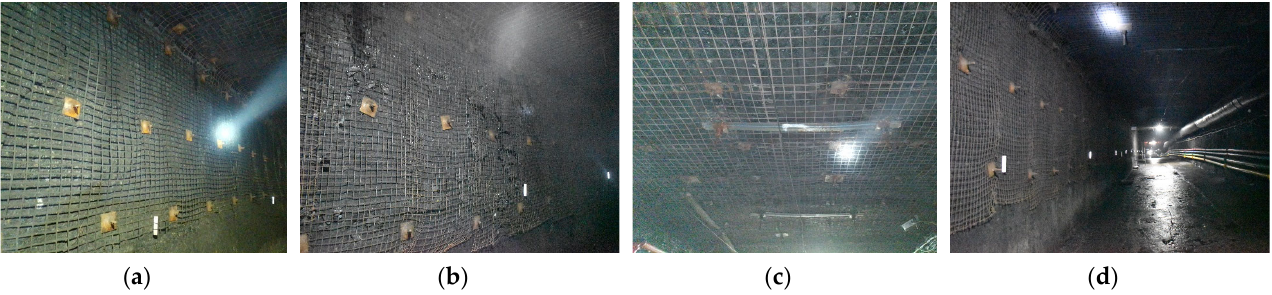
18 of 21 Figure 21. Borehole imaging diagram of the roof ‐ surrounding rock structure. In Figure 21, we see that there are only a few longitudinal cracks in the shallow road ‐ way roof, and the surrounding rock is complete within 5 m without cracks. Different from the adjacent RAR 23204 affected by mining, the roof crack development is serious, the rock mass is broken, and the roof shows stepped subsidence, so the maintenance of RAR 23205 is better and can meet the requirements of safe and efficient production in coal mines.